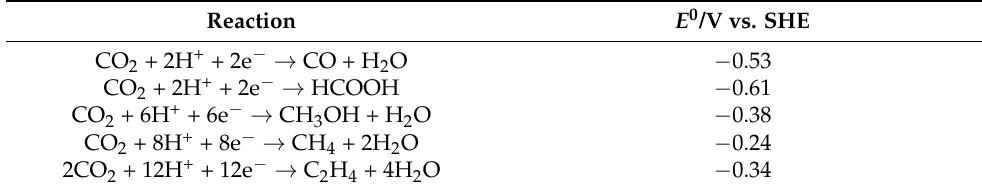
Table 1. The standard potentials for the electrochemical reduction of CO 2 [6].